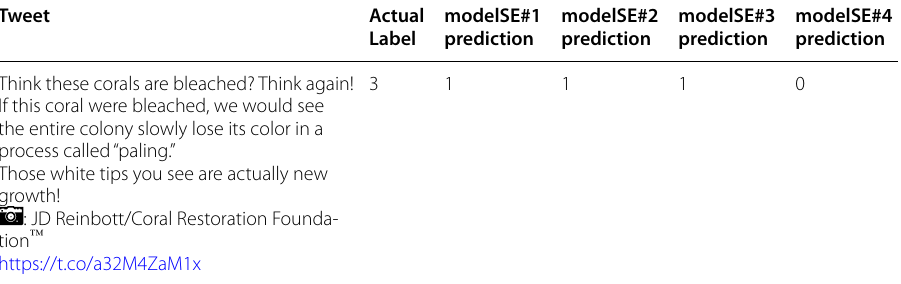
Table 8 Example of Buzz tweet which predicted as other class. Label 0 stand for Desirability, 1 stand for enabling context, and 3 stand for Buzz